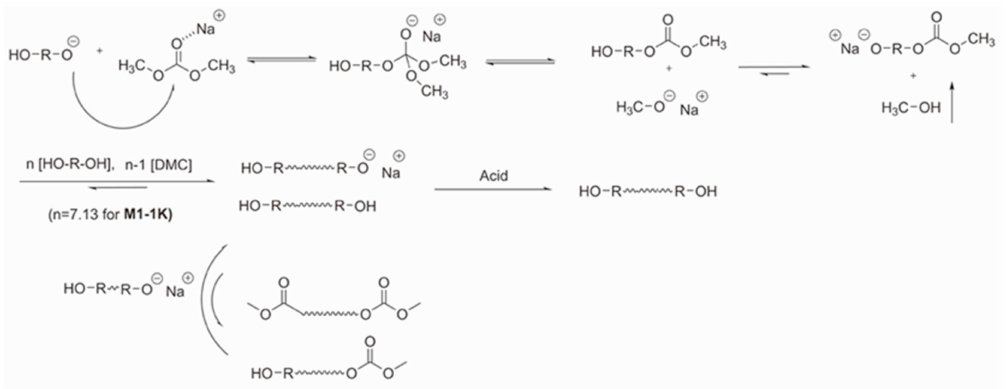
Scheme 2. Base-catalyzed polycondensation mechanism of diol and dimethyl carbonate (DMC) for the